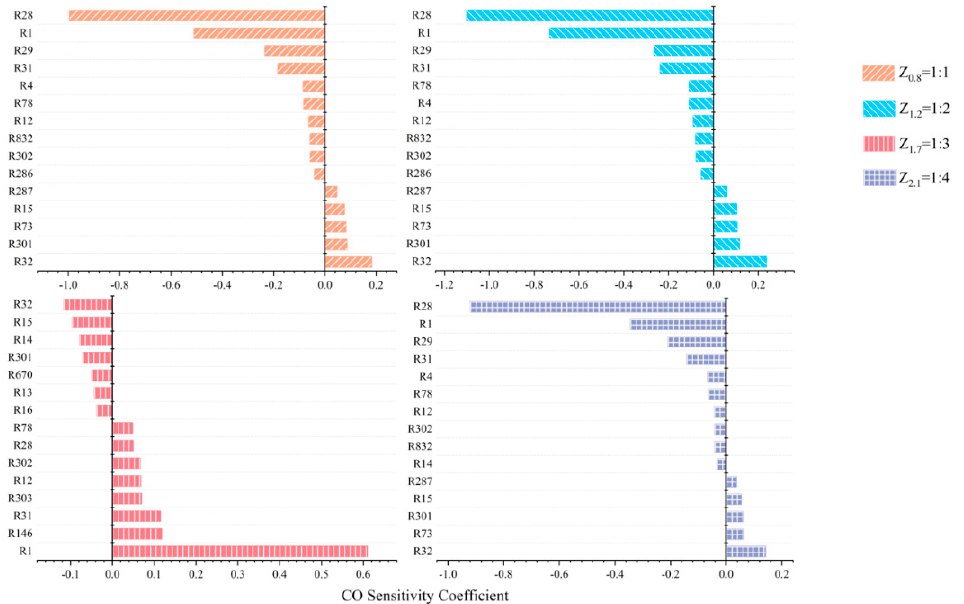
Figure 15. Comprehensive comparison of CO sensitivity analysis of air–light hydrocarbon mixing gas at the maximum mixing degree for equivalence ratios of n -pentane.